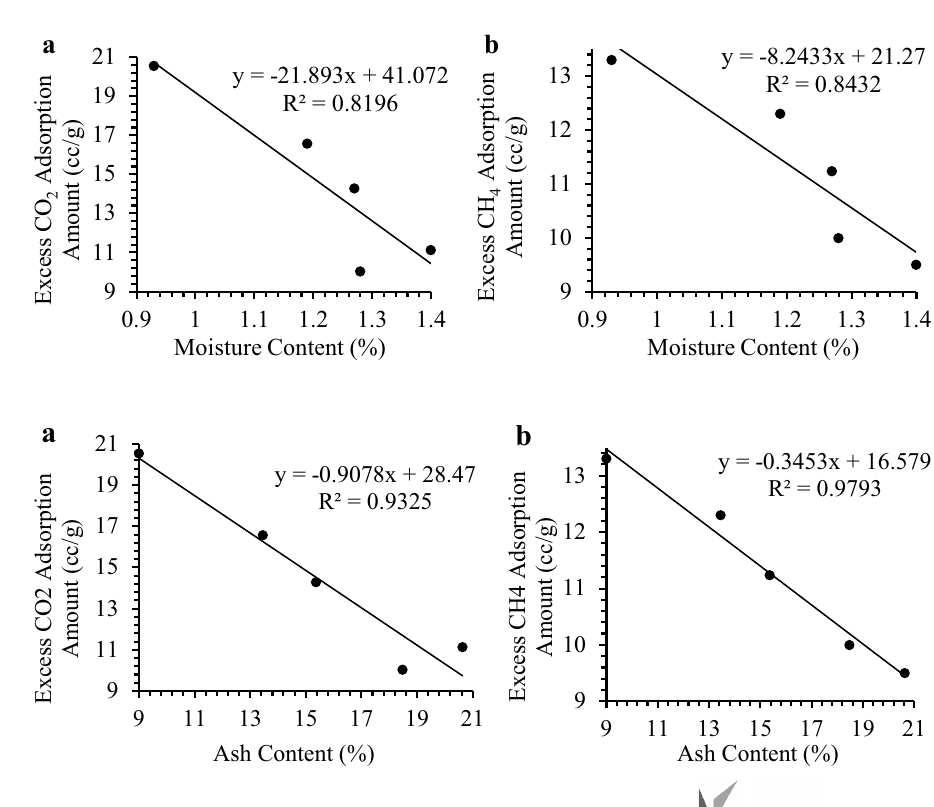
y = -21.893x + 41.072